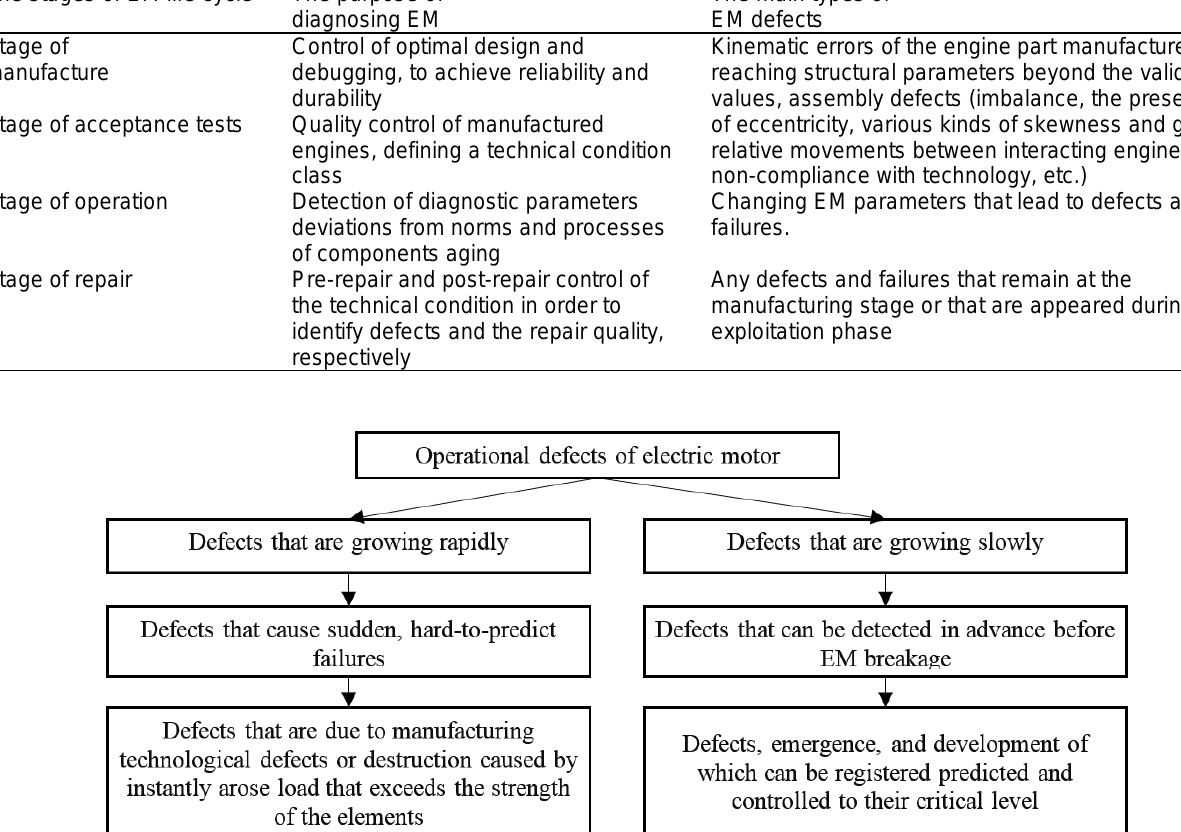
Figure 1. Categories of operational defects by the developmental